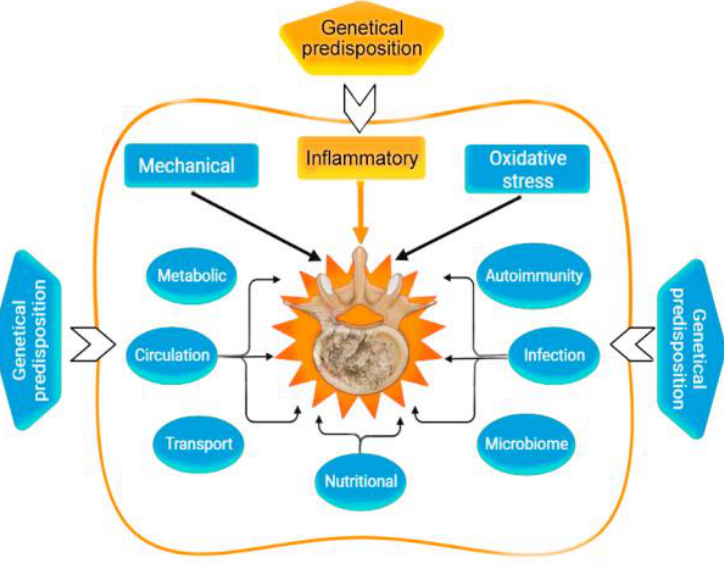
Figure 1. Risk factors of intervertebral disc degeneration.